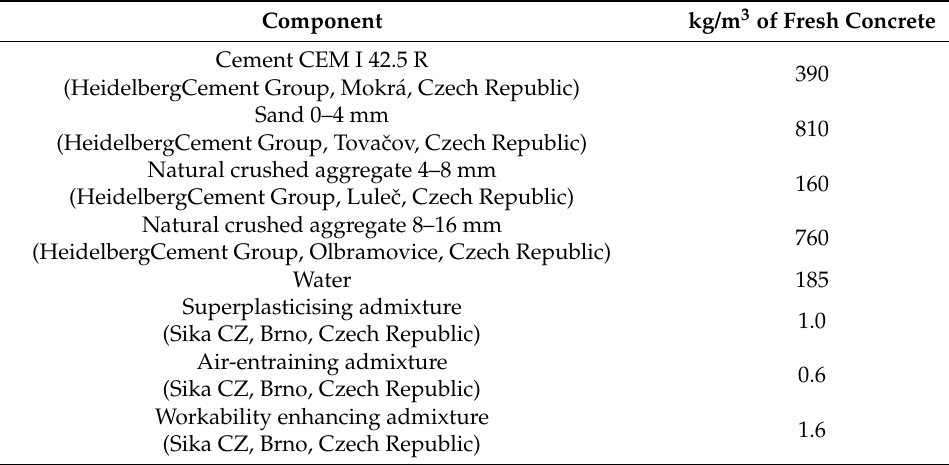
Table 1. Theoretical composition of the